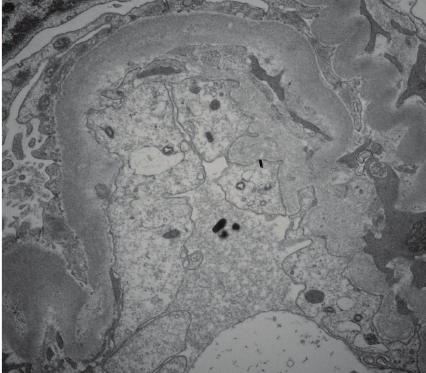
Figure 3: No evidence of electron dense, immune complex deposits by electron